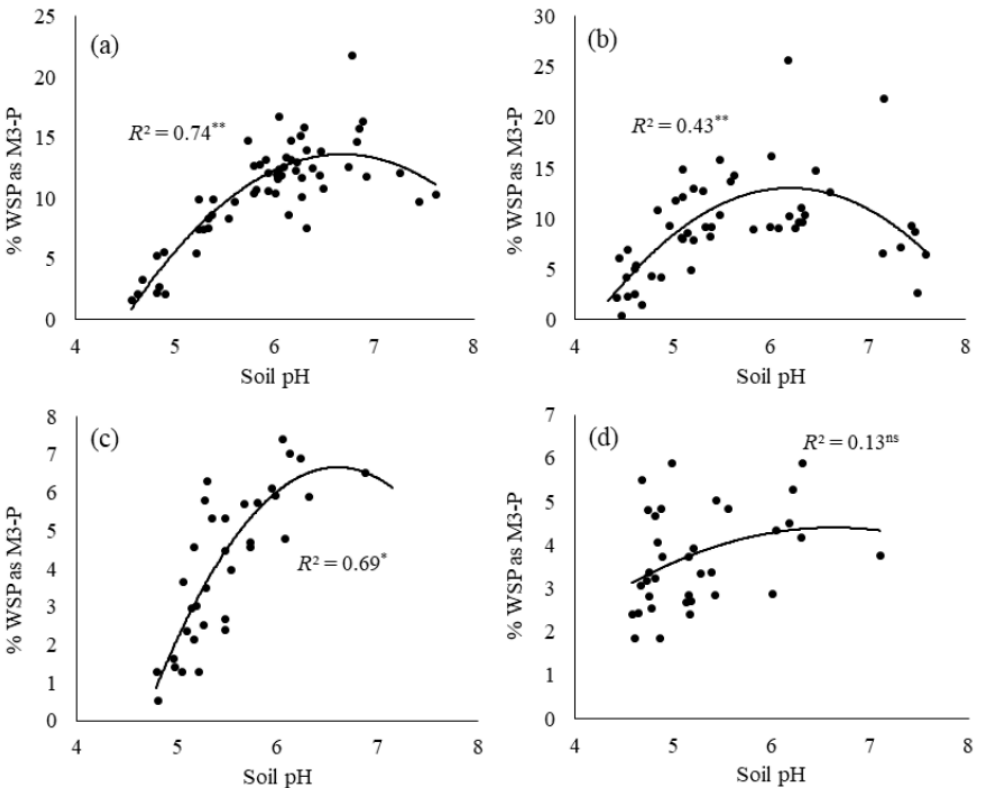
Figure 6. Impact of soil pH on the amount of water ‐ soluble phosphorus expressed as a percentage of Mehlich ‐ 3 phosphorus (%WSP as M3 ‐ P) for each location: ( a ) Chickasha, ( b ) Efaw, ( c ) Lahoma, and ( d ) Perkins. Total soil P was constant within each location. **, *: indicates significance at p < 0.01 and 0.05, respectively, for the second ‐ order linear regression model. ns: not significant.